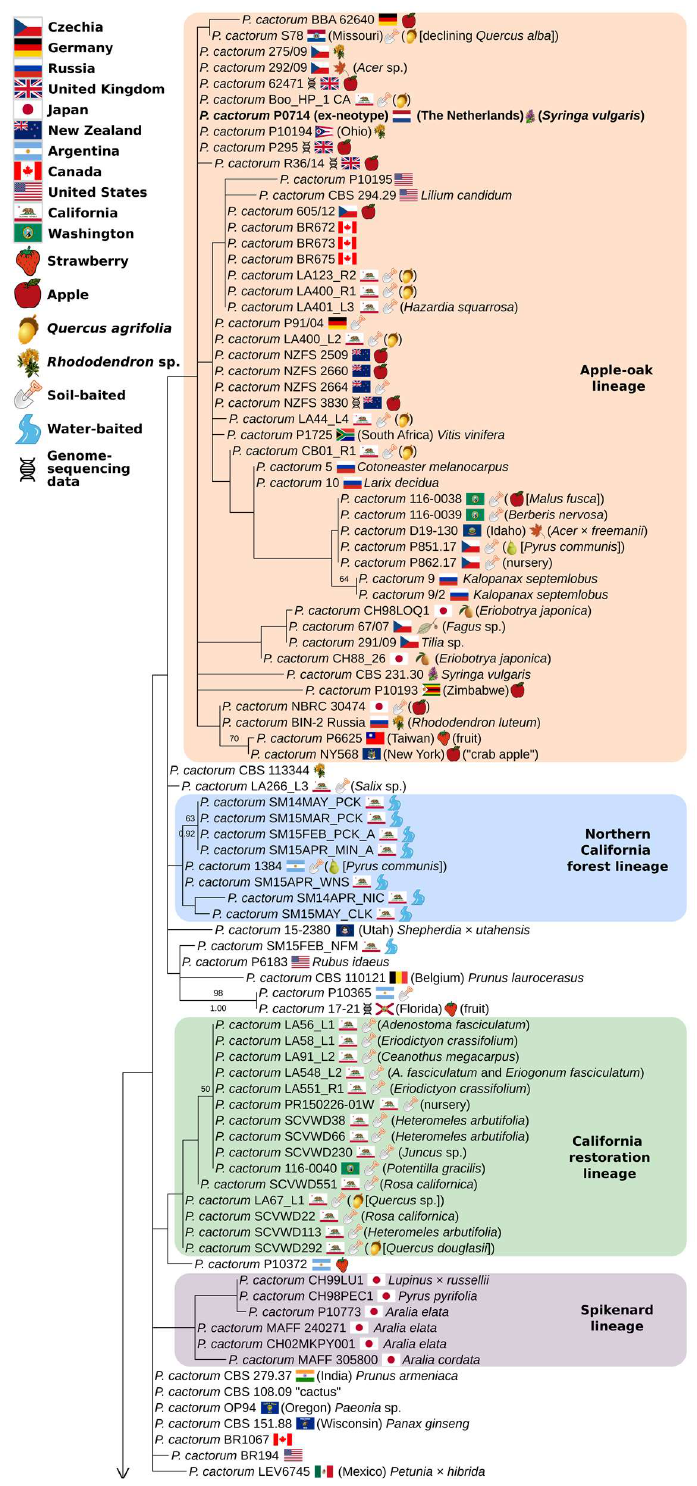
Figure 3. The 169-isolate, multi-locus maximum likelihood tree of Phytophthora subclade 1a (top). Tree inferred with IQTREE2 2.1.2 from ITS rDNA, mt cox2+spacer and mt cox1 loci, with a total of 2936 characters. Near-zero branches were collapsed with gotree (github.com/evolbioinfo/gotree, accessed 31 December 2021). Support values above branches are percentages ≥50 from 1000 non-parametric bootstrap replicates, and Bayesian posterior probabilities ≥0.90 from a separate analysis in MrBayes 3.2.7. Tree edited in TreeGraph2 and InkScape. Slashes indicate branches that were artificially shortened for display purposes. Sequence accessions are listed in Table S1.